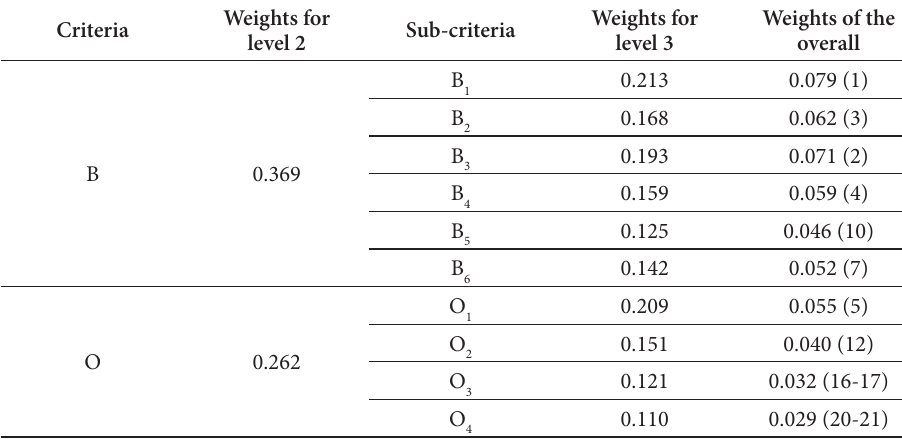
Table 2. Weights of the BOCR evaluation index by AHP